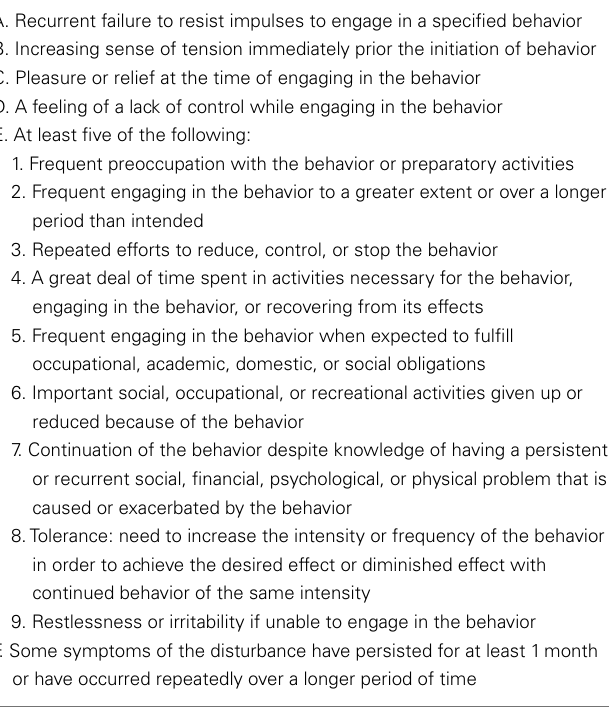
Table 2 |Addictive disorder criteria according to Goodman